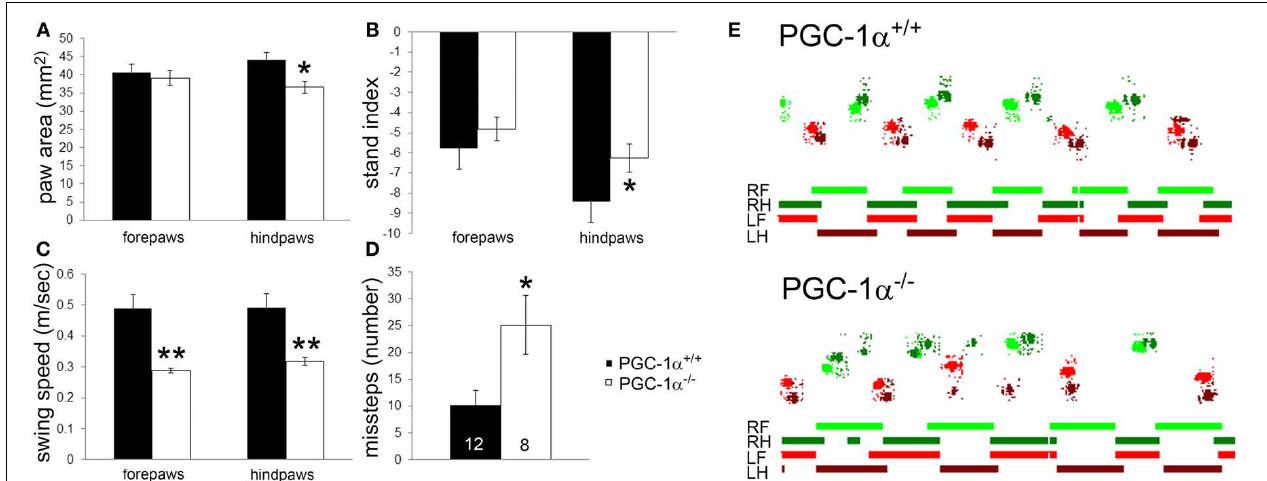
FIGURE 1 | Ataxia characterized by altered gait kinematics in mice lacking PGC-1 α . CatWalk gait analysis was performed on male PGC-1 α + / + and − / − littermates at 6 months of age. PGC-1 α − / − mice exhibited decreased hindpaw area (A) , increased hindpaw stand index (B) , decreased forepaw and hindpaw swing speed (C) , and an increased number of missteps (D)